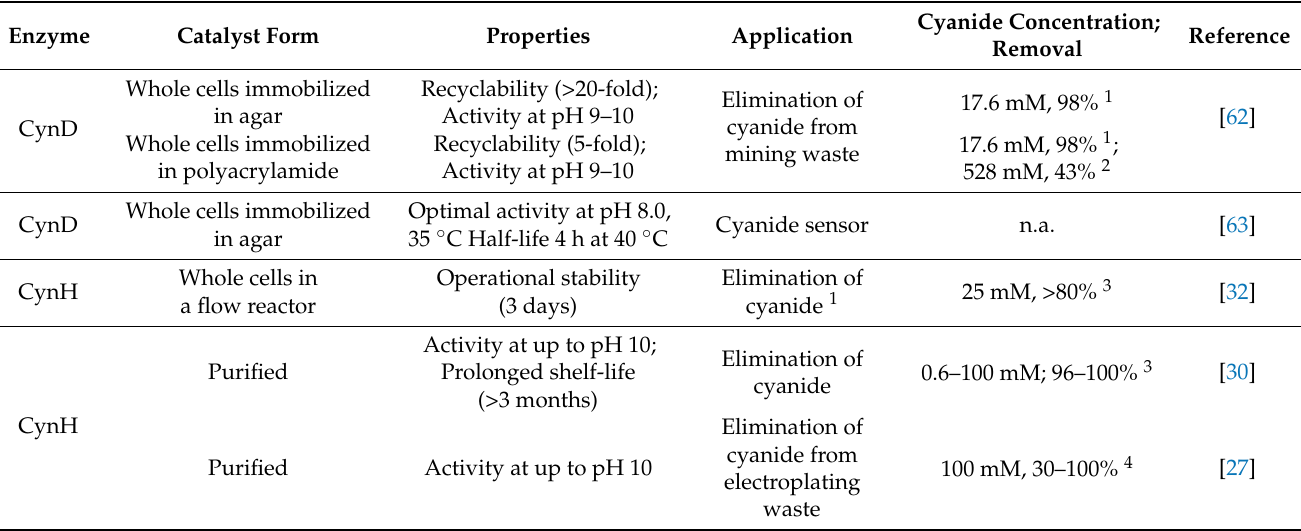
Table 6. Forms of catalysts for the degradation of free cyanide and their uses.